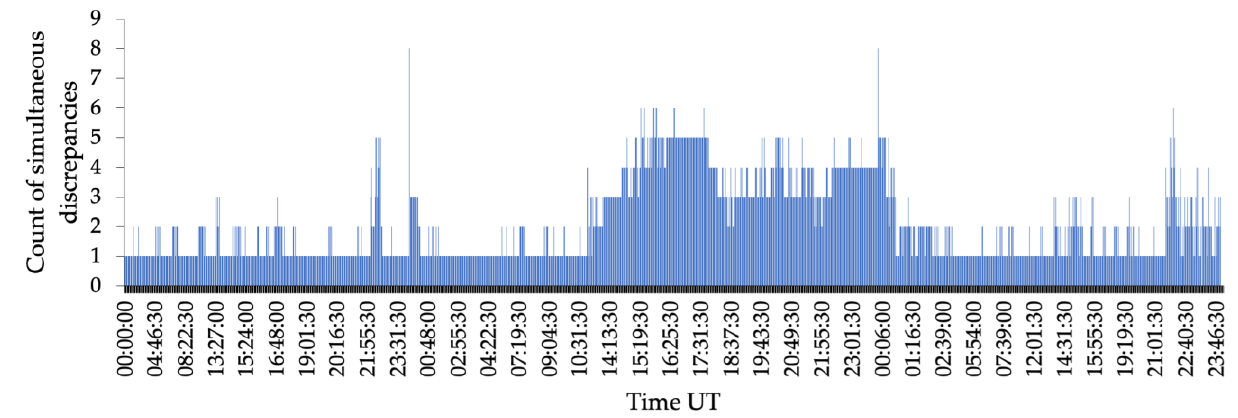
Figure 15. All faulty events and a count of faulty solutions on 16–18 March 2015, in the set of RIMS station solutions GVLA and GVLB, LAPA and LAPB, and WRSA and WRSB. From all the 57,600 90 s solutions which were performed in the six RIMS stations, the total count of faulty solutions on 16–18 March was 3269, i.e., 5.7% of faulty solutions occurred on a geomagnetic storm impact day. The results of the GVLA and GVLB stations were computed only for 17–18 March. The count of faulty solutions for each RIMS station is given in Table 4. Table 4. Total count of faulty solutions in selected RIMS stations. Station No.